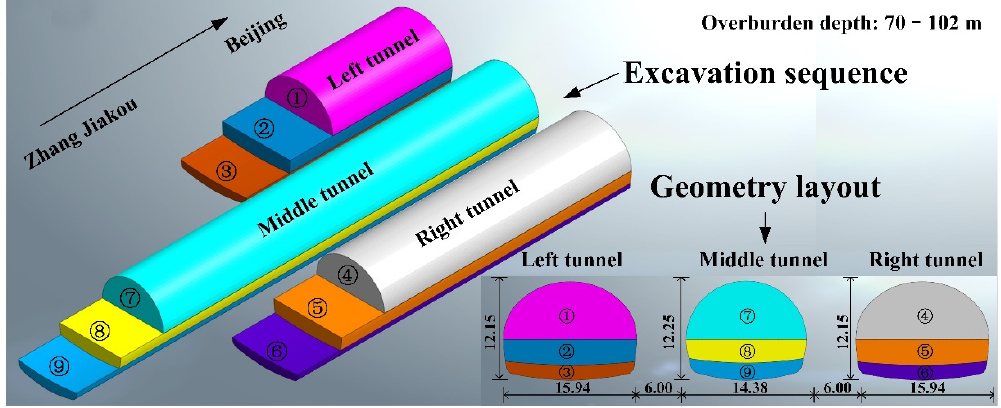
Figure 2. Excavation sequence and geometry layout of triple tunnels (Unit: m).